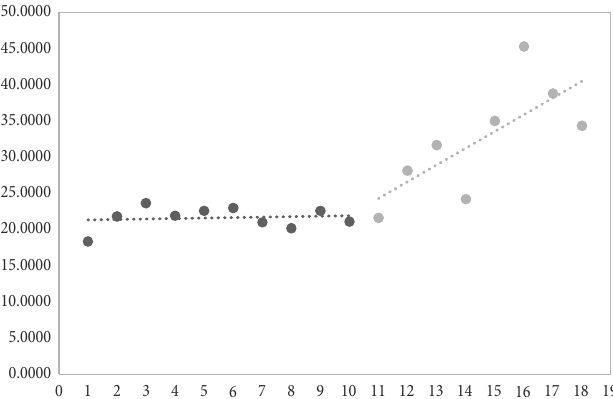
Fig. 5. Gross margin mean analysis: x axis – intangibles level groups in ascending order; y axis – mean value of gross margin (polynomial regression – Fig. 2A) Source: